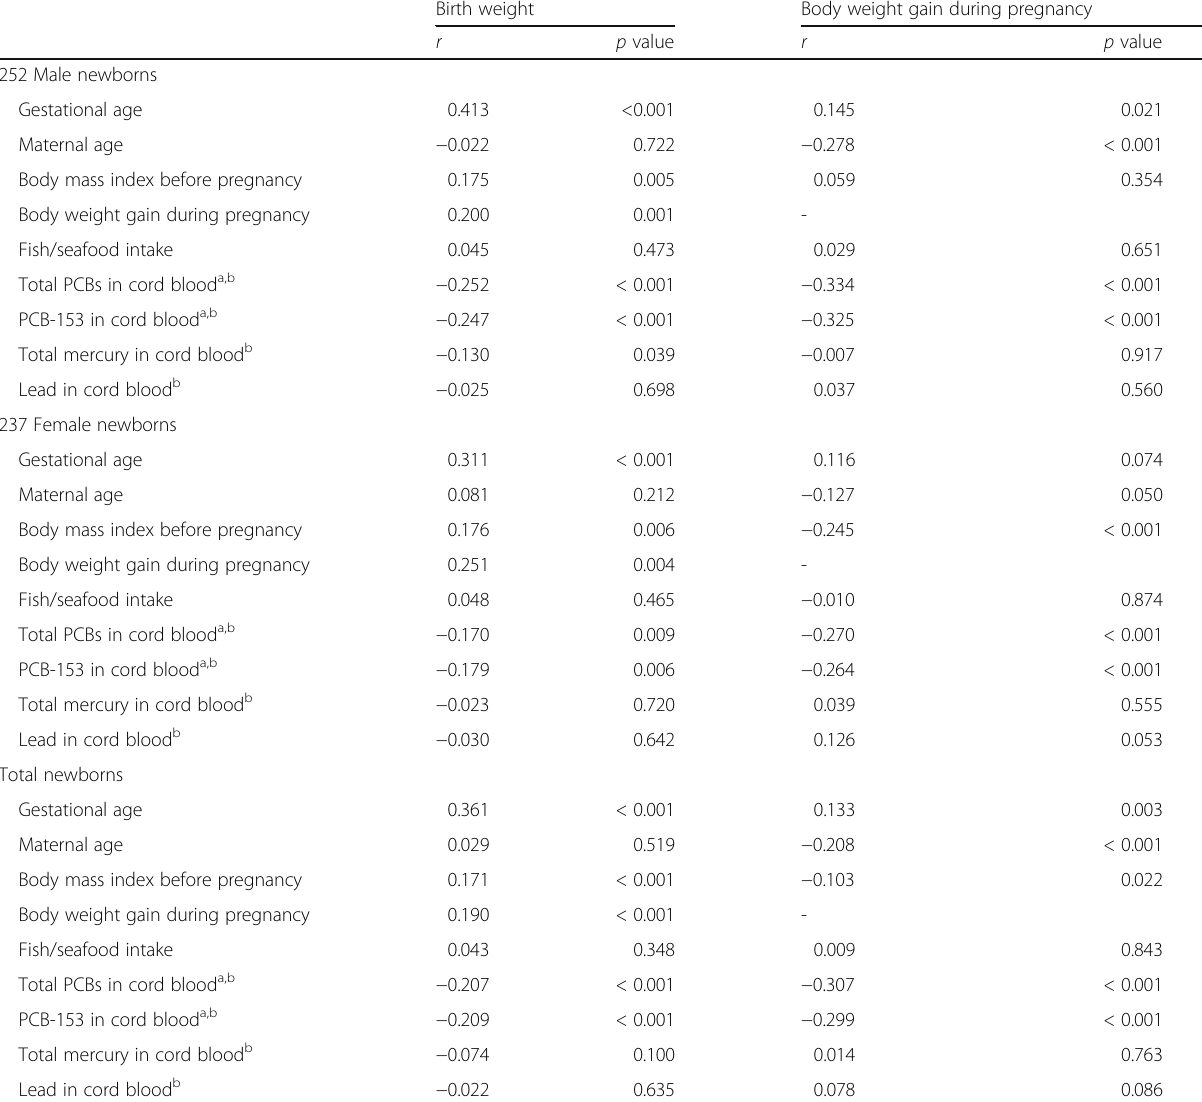
Table 2 Correlation coefficients ( r ) between birth weight and gestational weight gain and the relating